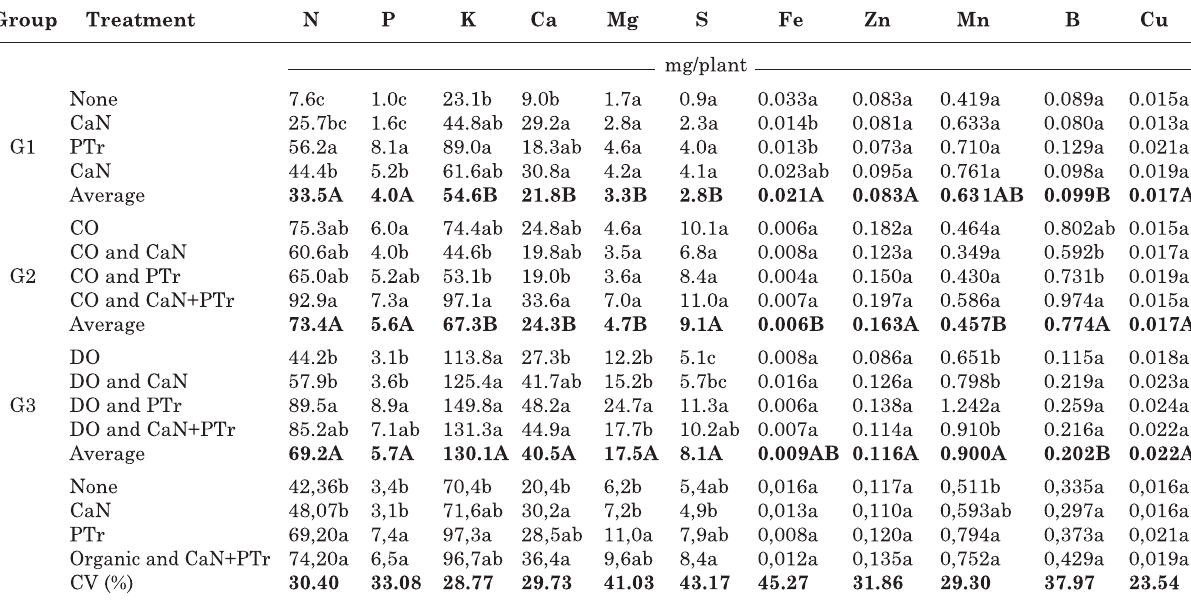
Table 5. Accumulation of macro- and micronutrients in plant shoot in response to the addition of organic or mineral